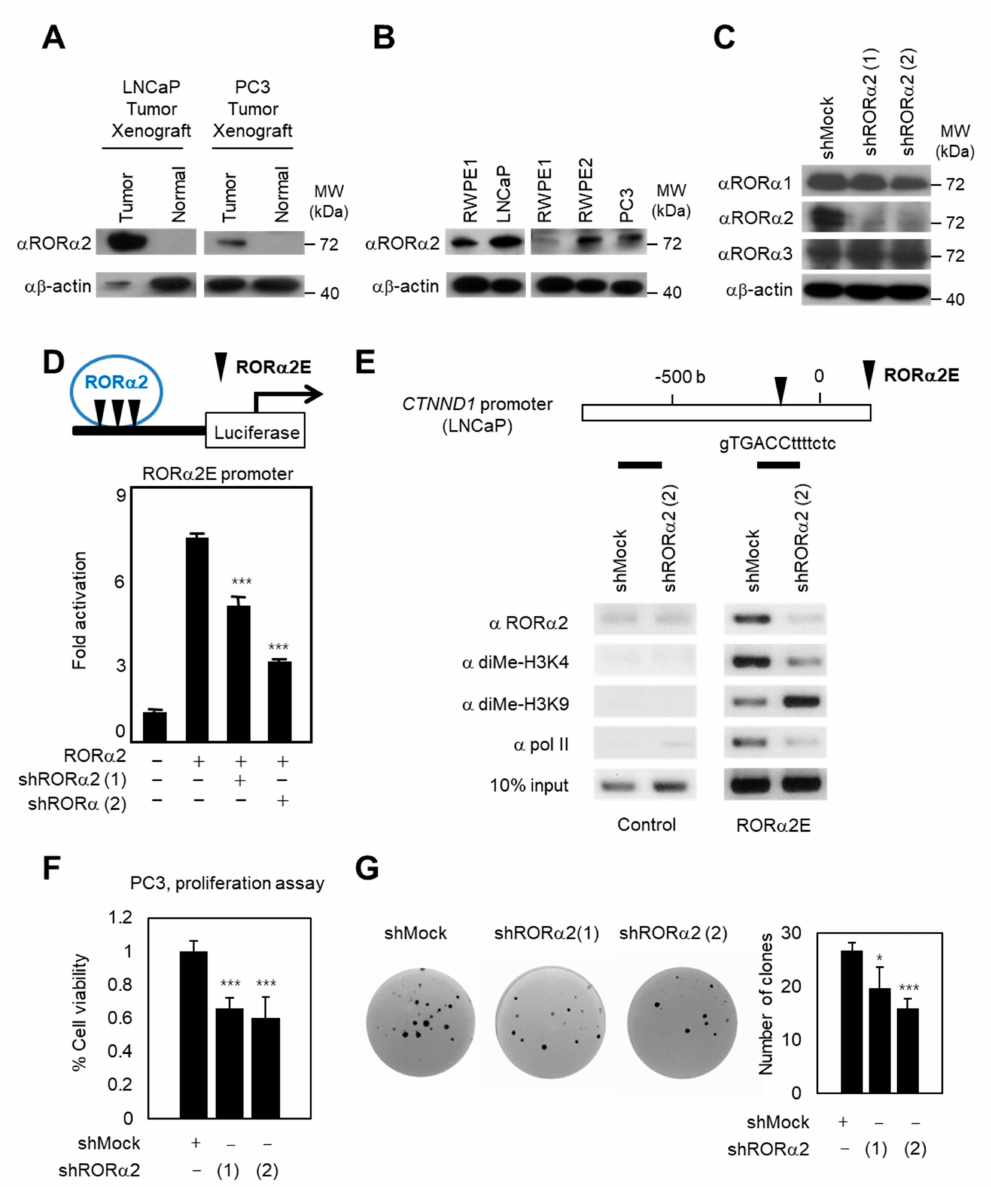
Figure 1. Retinoid acid-related orphan receptor α (ROR α 2) increases the proliferation and growth of prostate cancer (PCa) cells. ( A ) Lysates of xenograft tumors from LNCaP or PC3 cells were subjected to immunoblot analysis for ROR α 2 expression. ( B ) Expression of ROR α 2 in normal (RWPE1) and prostate cancer cell lines as assessed by immunoblotting. ( C ) E ffi cacy and specificity of knockdown by two individual short hairpin RNAs (shRNAs) against ROR α 2 are shown by immunoblot analysis against ROR α 1, 2, and 3 antibodies. ( D ) Introduction of shROR α 2 decreased transcriptional activation of the ROR α 2E-luciferase reporter. Data are represented as means ± SD for three independent experiments. Statistical significance was calculated by a two-tailed, unpaired t -test (*** p < 0.001). ( E ) ChIP assay on the CTNND1 promoter luciferase reporter in LNCaP cells with or without shRNA of ROR α 2. shROR α 2 (2) was used as representative for this assay, and occupancy of the control or ROR α 2E in CTNND1 promoter by ROR α 2, di-methyl H3K4, di-methyl H3K9, and polymerase II was analyzed. ( F ) The MTS cell proliferation assay of PC3 cells expressing shMock or shROR α 2. MTS absorbance was determined at 490 nm. ( G ) Photographs from the clonogenic assay of PC3 cells expressing shRNA against ROR α 2. The number of colonies was quantified in control and shROR α 2-expressing PC3 cells, as shown in the right panel. Statistical significance was calculated by a two-tailed, unpaired t -test (* p < 0.05, *** p <